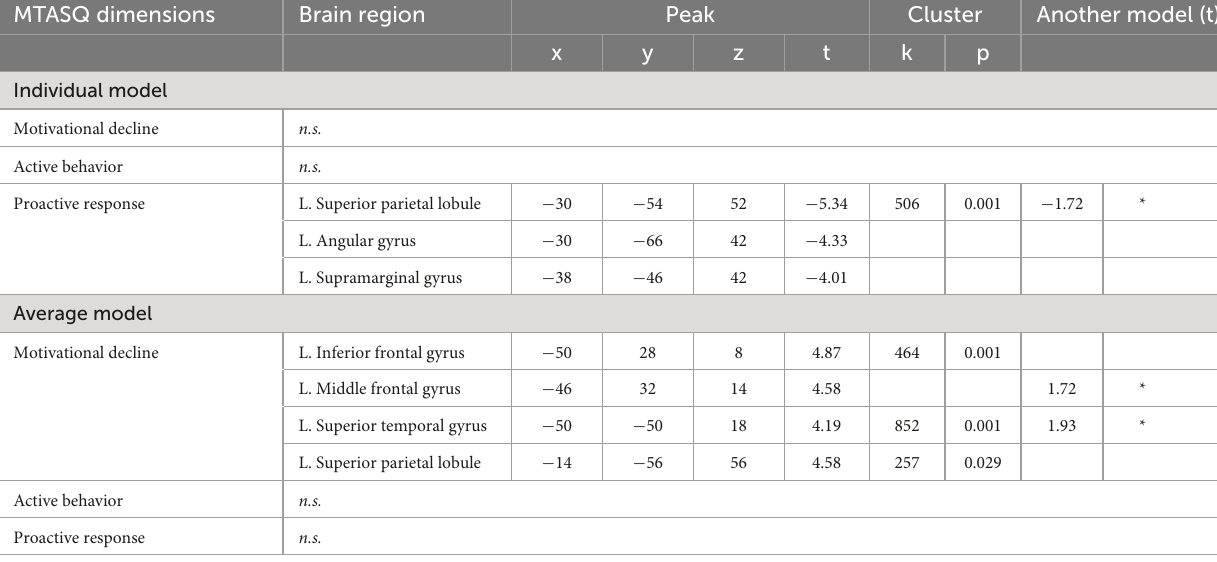
TABLE 5 Significant effects of the MTASQ score on discomfort-related activation (second approach). MTASQ dimensions Brain region